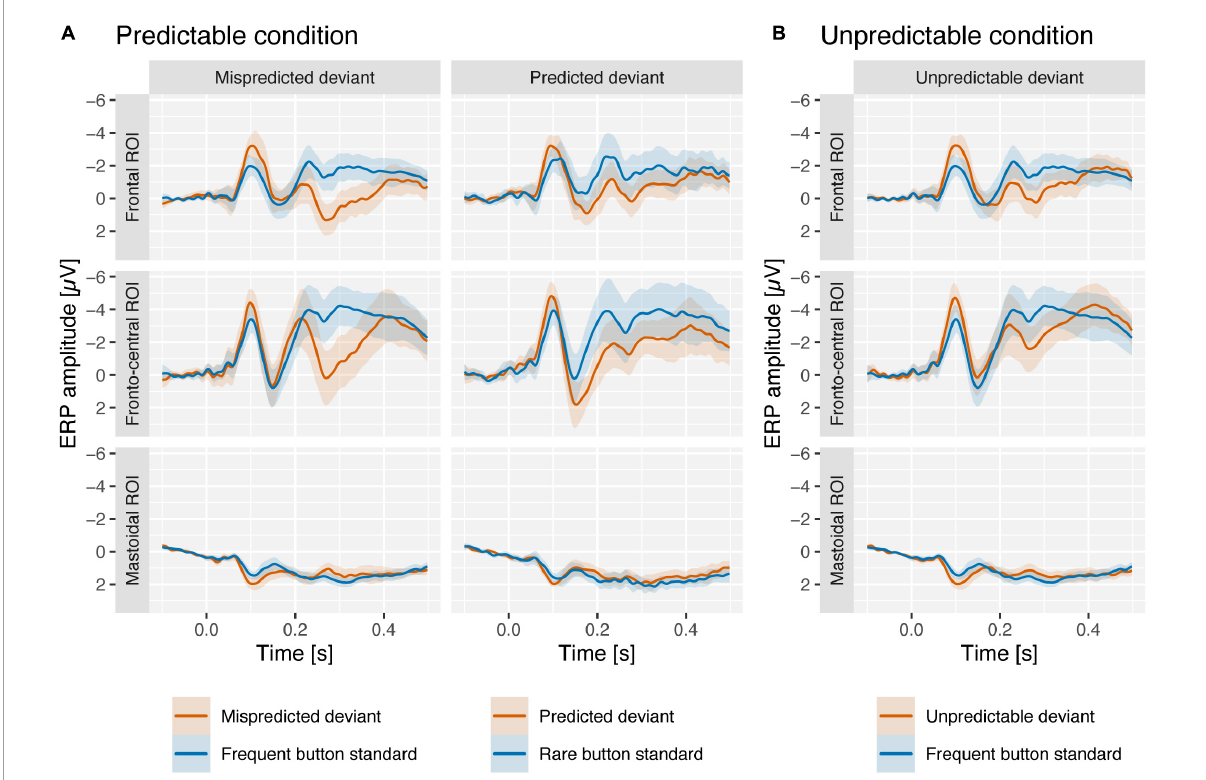
FIGURE2 Grand-average ERPs at frontal ROI (FC5 and FC6), fronto-central ROI (Fz, FC1, FC2, and Cz), and mastoidal ROI (M1 and M2) from predictable (A) and unpredictable conditions (B) in response to mispredicted and predicted deviants (predictable condition; red) and unpredictable deviants (unpredictable condition; red). Deviants from both conditions are compared to frequent and rare button standards (blue) from the unpredictable condition (see “Materials and methods” section). Shaded areas reflect 95% confidence intervals. At around 100–150 ms ERPs are more negative for deviants than for standards at frontal and fronto-central regions, and more positive on mastoidal areas. At around 200–400 ms the ERPs for standards were more positive for deviants than for standards at fronto-central